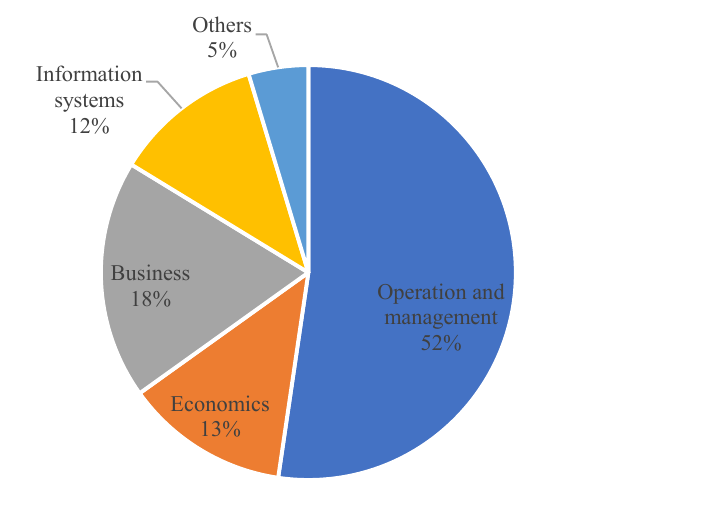
Figure 4. Distribution of research fields